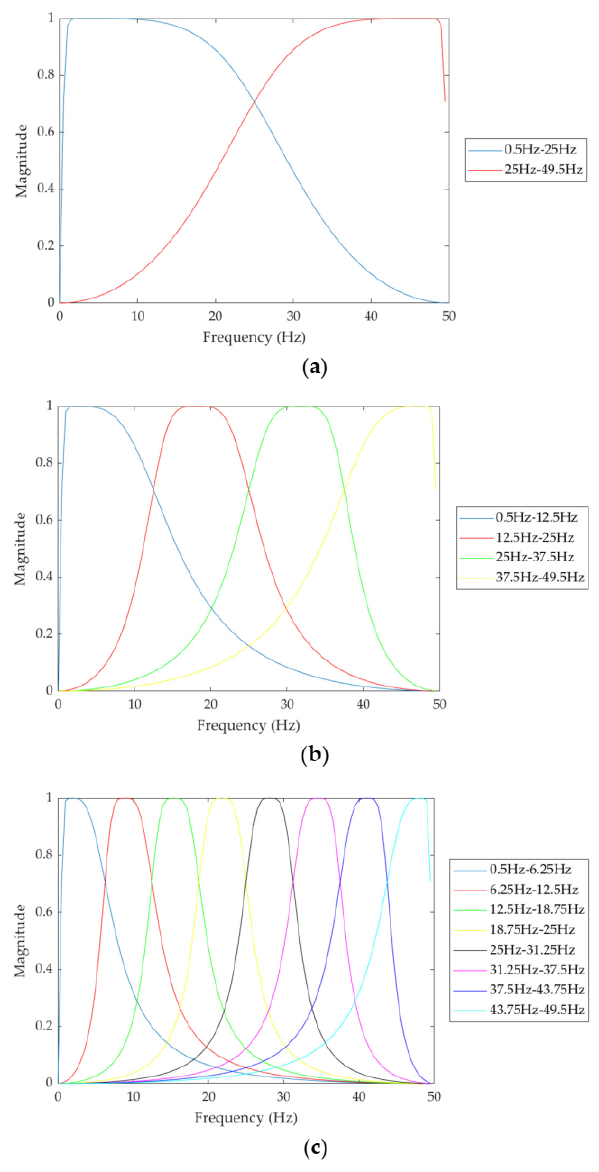
Figure 2. Magnitude responses of the filter banks including ( a ) 2, ( b ) 4, and ( c ) 8 Butterworth bandpass